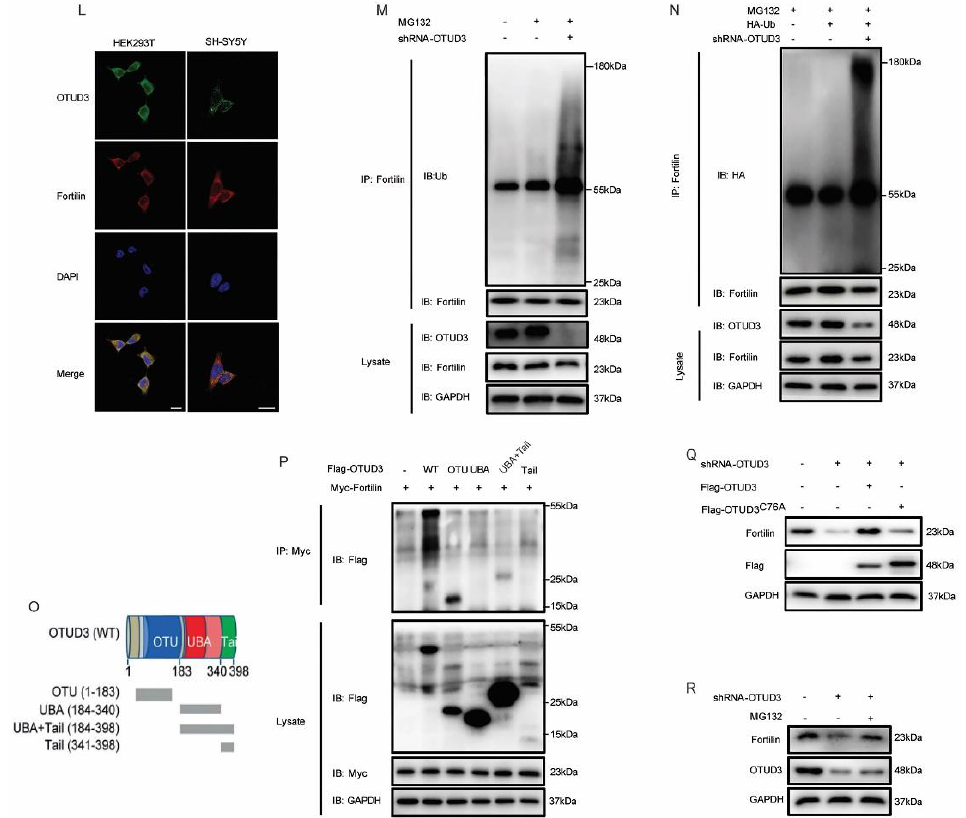
Figure 5. OTUD3 regulates the ubiquitination level of Fortilin protein. ( A ) The interaction be- tween IRE1 α and Bip, Fortilin and OTUD3 were examined immunoprecipitated with anti-IRE1 α antibody. The whole-cell lysate was subjected to immunoblot with anti-IRE1 α , anti-Bip, anti-OTUD3 and anti-Fortilin antibody. ( B , C ) The interaction between Fortilin and IRE1 α and OTUD3 were examined immunoprecipitated with anti-Fortilin antibody. The whole-cell lysate was subjected to immunoblot with anti-IRE1 α , anti-OTUD3 and anti-Fortilin antibody. ( D – K ) Western blotting and statistical analysis of the expression of Fortilin in OTUD3 knockdown cells, OTUD3 − / − mice, SH-SY5Y cells transfected with Myc-OTUD3 and OTUD3 transgenic mice, n = 5. ( L ) OTUD3 and Fortilin colocalized in the cytoplasm of HEK293T and SH-SY5Y cells. ( M , N ) The ubiquitylation levels of Fortilin was determined by in vitro ubiquitin conjugation assay. n = 3. ( O , P ) Co-IP assays were performed to map the domain of Fortilin required for interaction with OTUD3 ( n = 3). ( Q ) Western blotting was examined the expression of Fortilin in OTUD3 knockdown cells after transfected with Flag-OTUD3 WT and Flag-OTUD3 C76A . n = 3. ( R ) Western blotting was examined the expression of Fortilin in OTUD3 knockdown cells after treatment with MG132. n = 3. Data were mean ± SEM, t -test, * p < 0.05, ** p <